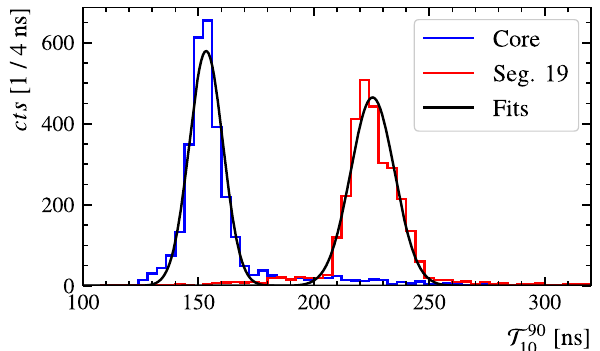
Fig. 22 Distribution of the rise time T 90 of the measurement at ϕ = 262 . 9 ◦ from the scan AST. Also shown are scaled Normal distributions fitted to the